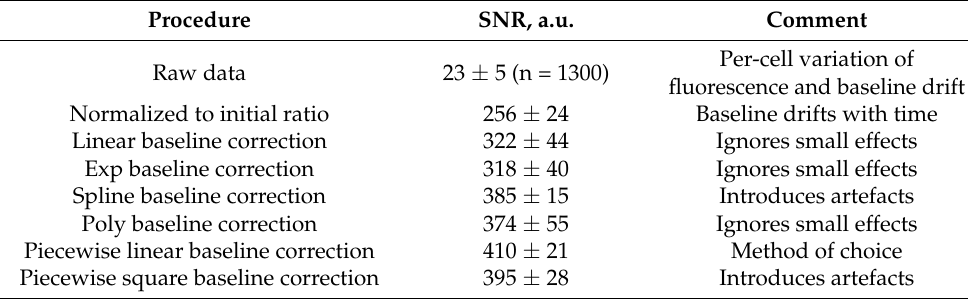
Table 1. Signal-to-noise ratio improvement after data correction